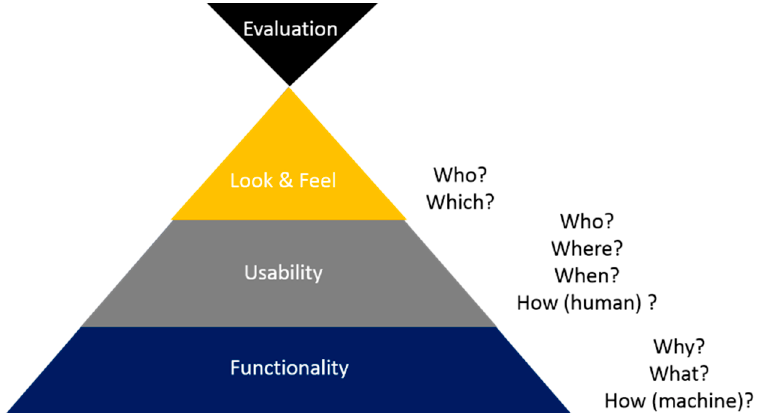
Figure 2. The FULE methodology is built like a pyramid, meaning there is a clear hierarchy.